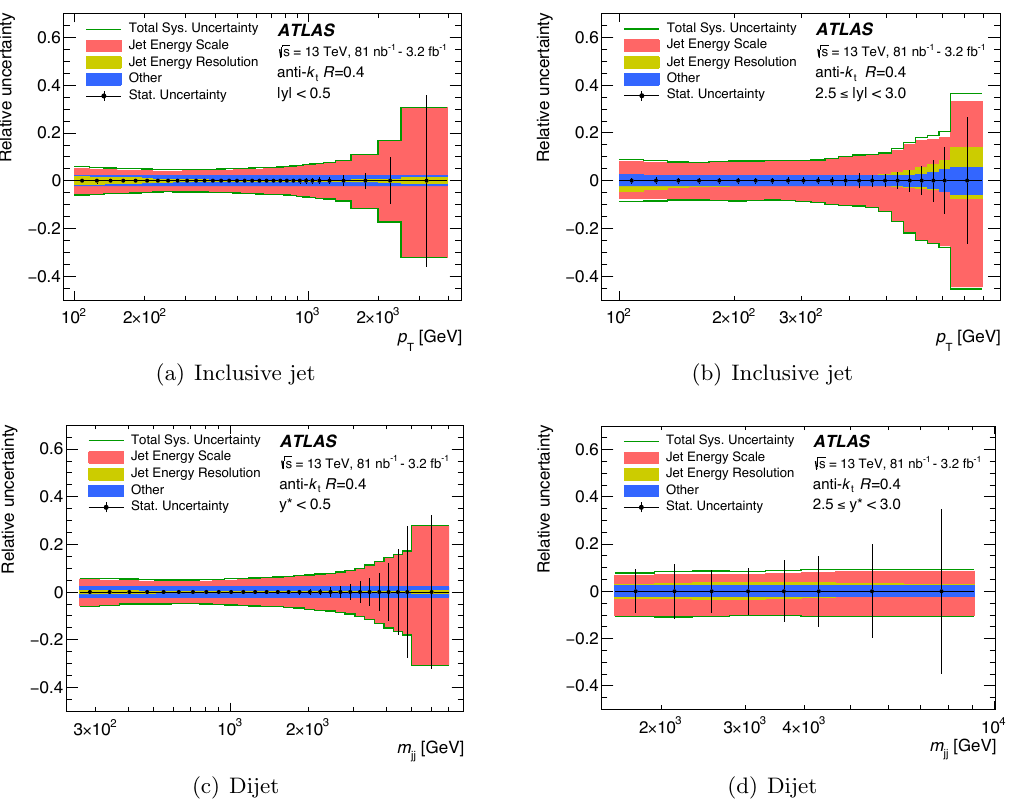
Figure 1 . Relative systematic uncertainty for the inclusive jet cross-section as a function of the jet p T for the (cid:12)rst and last rapidity bins ((a) and (b) respectively) and for the dijet cross-section as a function of m jj for the (cid:12)rst and last y (cid:3) bins ((c) and (d) respectively). The individual uncertainties are shown in di(cid:11)erent colours: the jet energy scale, jet energy resolution and the other uncertainties (jet cleaning, luminosity and unfolding bias). The total systematic uncertainty, calculated by adding the individual uncertainties in quadrature, is shown as a green line. The statistical uncertainty is shown as vertical black